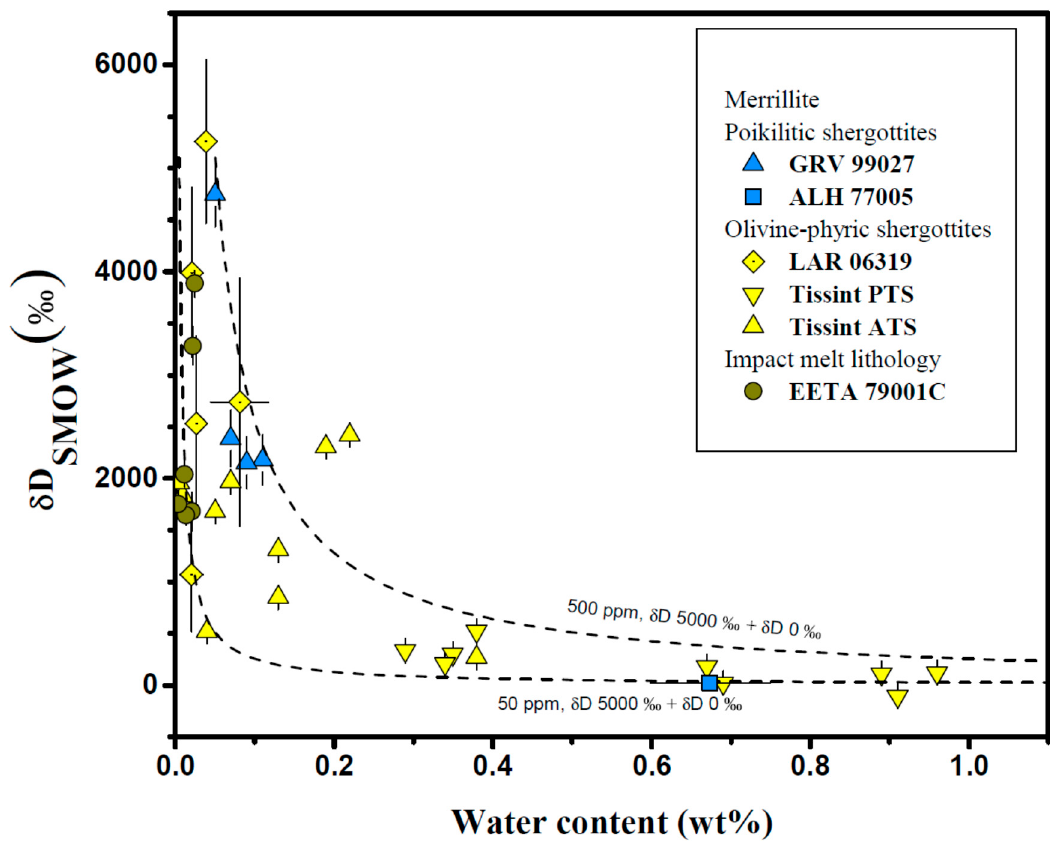
Figure 3. The relationship between water content and δ D values of the merrillite grains from Martian shergottites. All of the datasets depict a negative trend regardless of petrographic type. GRV 99027 from [63], ALH 77005 from [59], LAR 06319 from [69], Tissint from [52], and EETA 79001C from [71]. PTS: polished thin section, ATS: anhydrously prepared thick section.